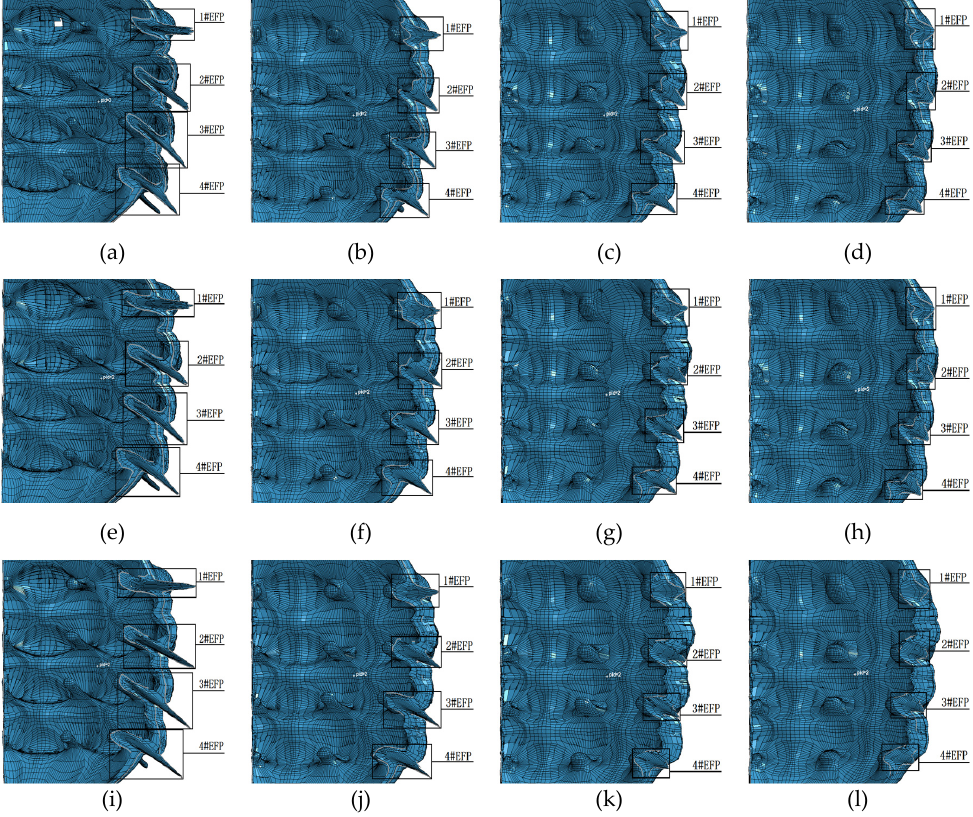
Figure 4. Forming results of integral circumferential MEFP warhead projectile: ( a ) Scheme 1 forming results; ( b ) Scheme 2 forming results; ( c ) Scheme 3 forming results; ( d ) Scheme 4 forming results; ( e ) Scheme 5 forming results; ( f ) Scheme 6 forming results; ( g ) Scheme 7 forming results; ( h ) Scheme 8 forming results; ( i ) Scheme 9 forming results; ( j ) Scheme 10 forming results; ( k ) Scheme 11 forming results; ( l ) Scheme 12 forming results.